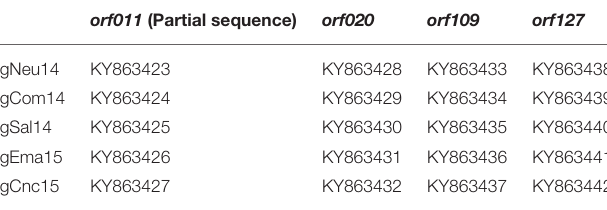
TABLE 1 | Gen Bank accession number of Argentinian ORFV